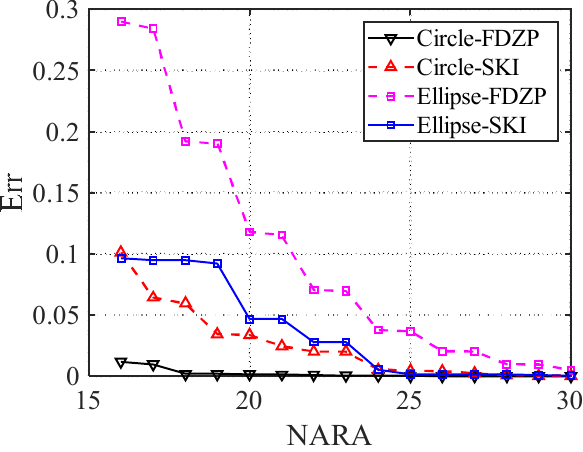
Table 1. The minimum NARA required by FDZP method and skeletonization-based method when the interpolation error was less than 1%.